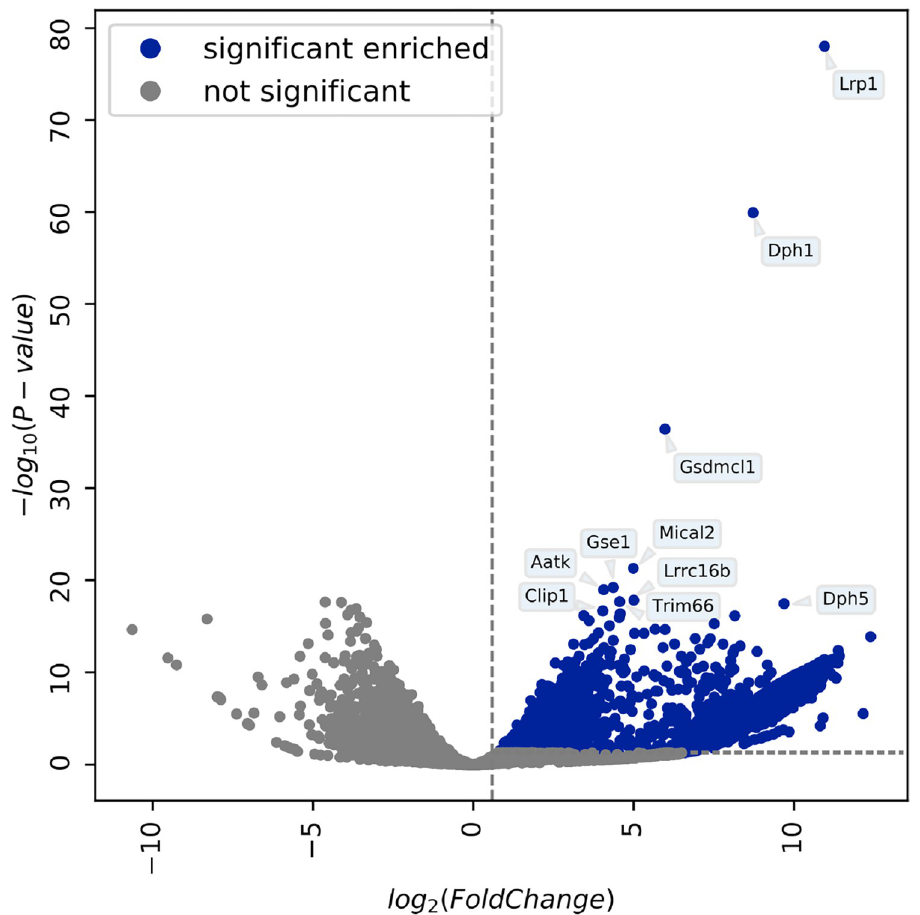
Fig 2. Volcano plot showing significantly enriched genes. The volcano plot shows gene expression changes between cells surviving treatment with usually lethal PMT-DTa chimera and those only transduced with the CRISPR library. All reads were mapped locally using BWA-MEM [5,6], then quantified with featureCounts [4], and finally fold changes between the condition were calculated by DESeq2 [7] (see galaxy history). The volcano plot was drawn with the bioinfokit toolkit [8]. Significantly enriched genes, having a positive fold change above 0.584 and a p-value lower or equal 5%, are shown in blue. The significance thresholds are marked by gray-dotted lines. The ten most significant genes are highlighted with their name. Non-significant genes are colored in